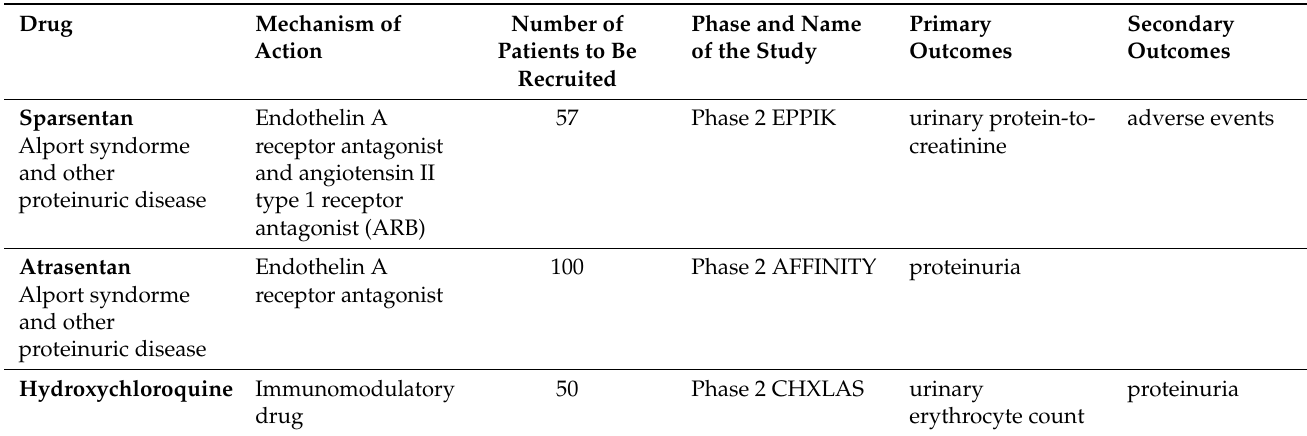
Table 2. Recruiting clinical trials in